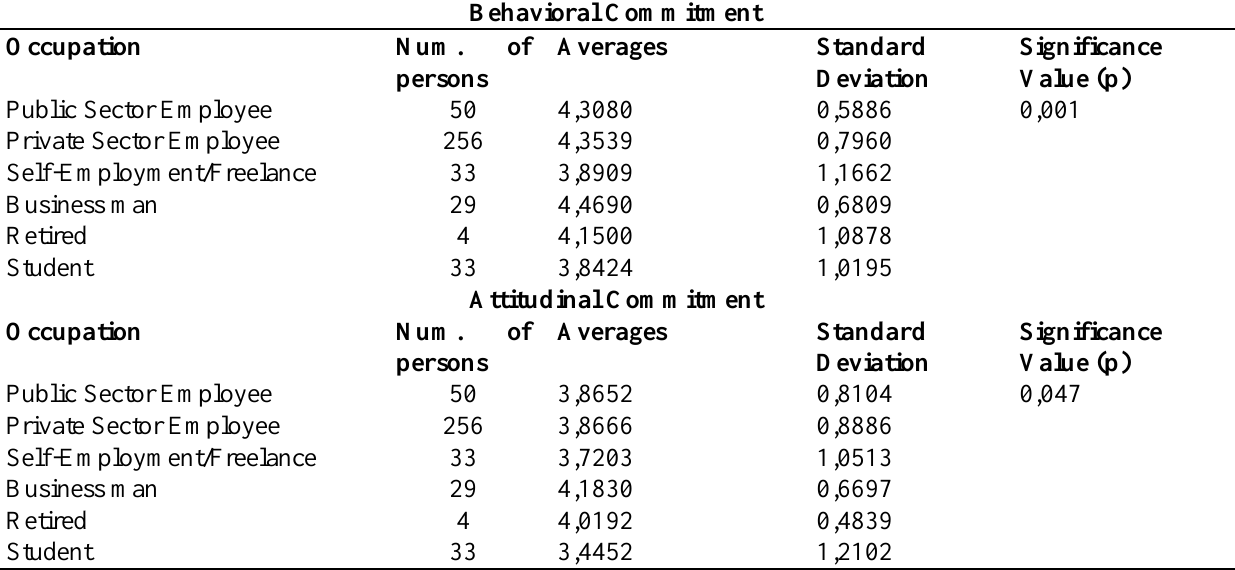
Table 16. Comparison of views on customer loyalty according to profession